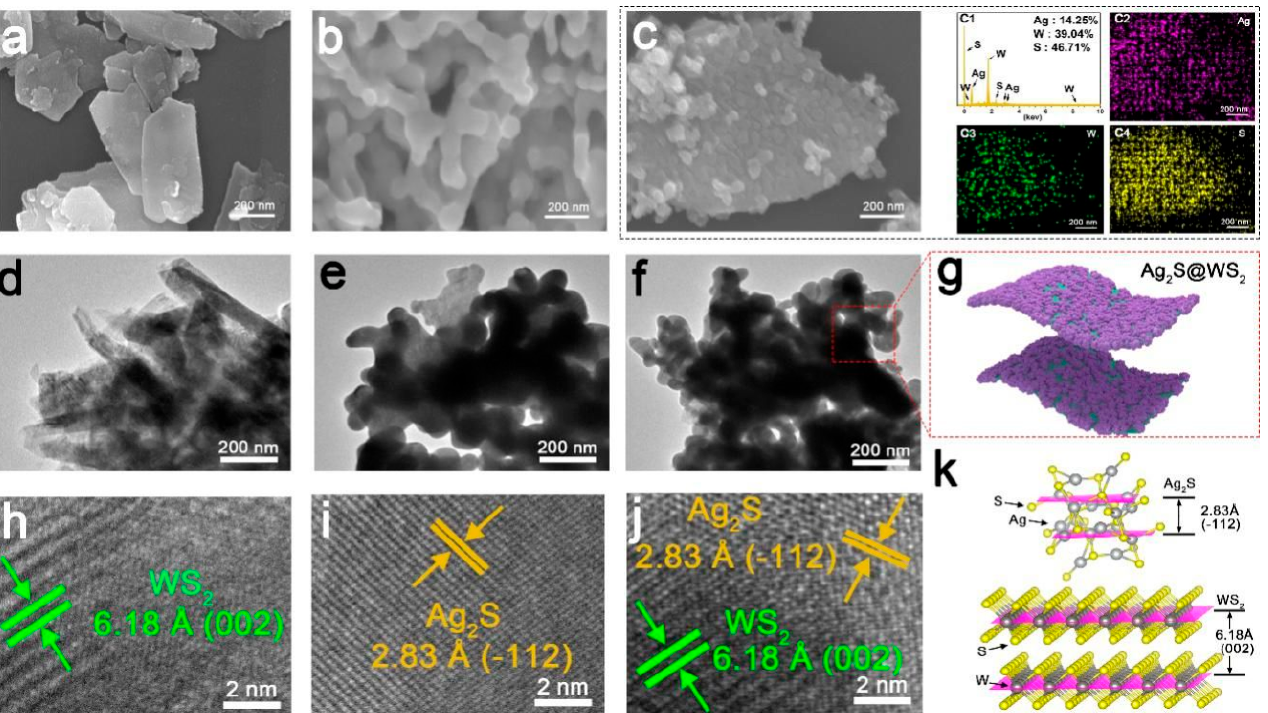
Figure 4. SEM, TEM, EDS, and crystal structure of Ag 2 S, WS 2 , and Ag 2 S–WS 2 . ( a ) WS 2 , ( b ) Ag 2 S, ( c ) Ag 2 S–WS 2 , ( d ) TEM image of WS 2 , ( e ) TEM images of Ag 2 S, ( f ) TEM image of Ag 2 S–WS 2 , ( g ) morphology of Ag 2 S–WS 2 , ( h ) HR-TEM image of WS 2 , ( i ) HR-TEM image of Ag 2 S, ( j ) HR-TEM image of Ag 2 S–WS 2 , and ( k ) crystal structure of Ag 2 S, and WS 2. The image was reproduced with permission